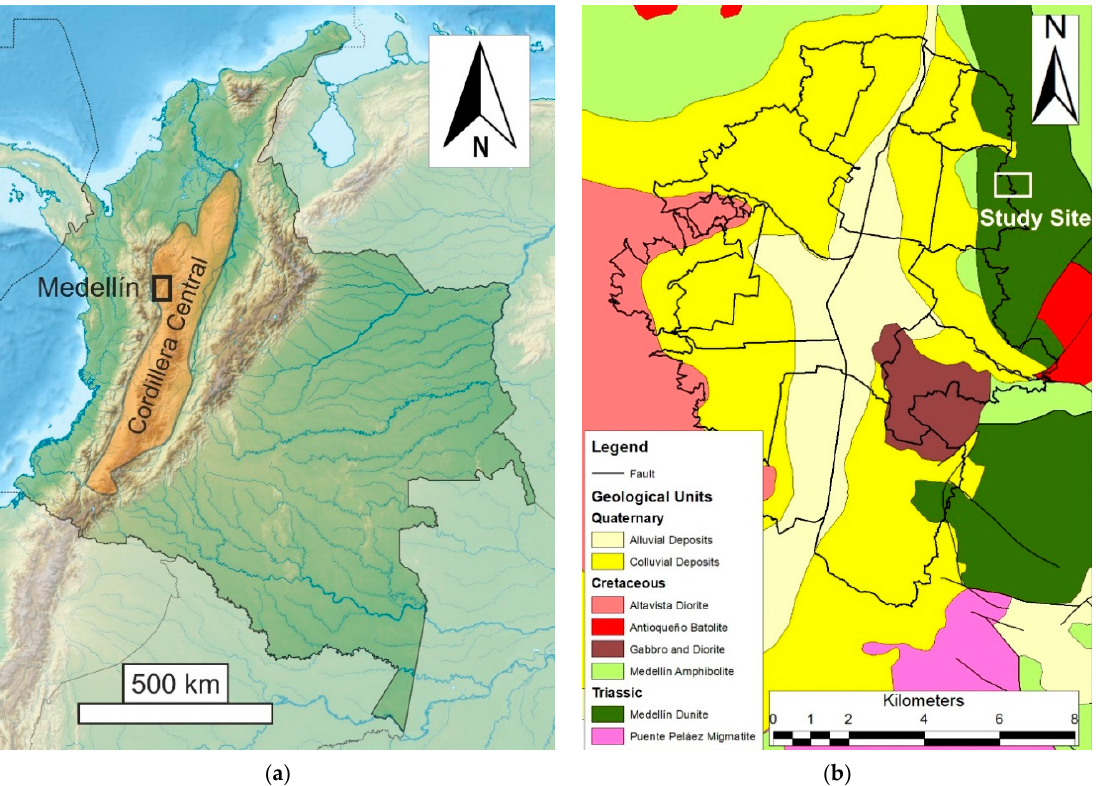
Figure 1. ( a ) Location of Medellín within Colombia and the Cordillera Central; ( b ) The “Comunas” of Medellín (black contours), the location of the study site and the city’s geological units [11] .